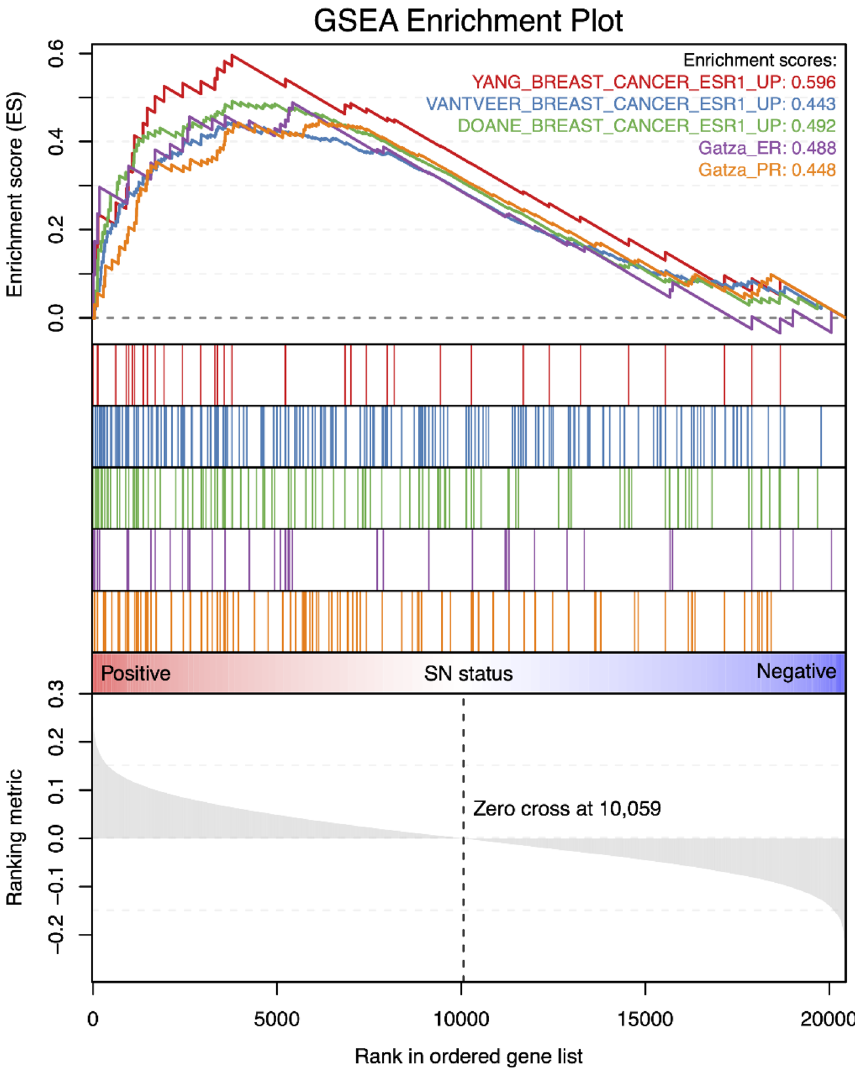
Figure 3. Barcode Enrichment Plot of the five signatures; Gatza_ER (purple), Gatza_PR (orange), “DOANE_ BREAST_CANCER_ESR1_UP” (green), “VANTVEER_BREAST_CANCER_ESR1_UP” (blue) and “YANG_ BREAST_CANCER_ESR1_UP” (red). All genes from the BasL samples ( n = 170) are ranked along x-axis according to enrichment score (y-axis). There is a significant upregulation of the five investigated gene sets in patients with a positive SN status, and the ranked position of each gene within a signature is shown in the middle panel. Figure created using R 32